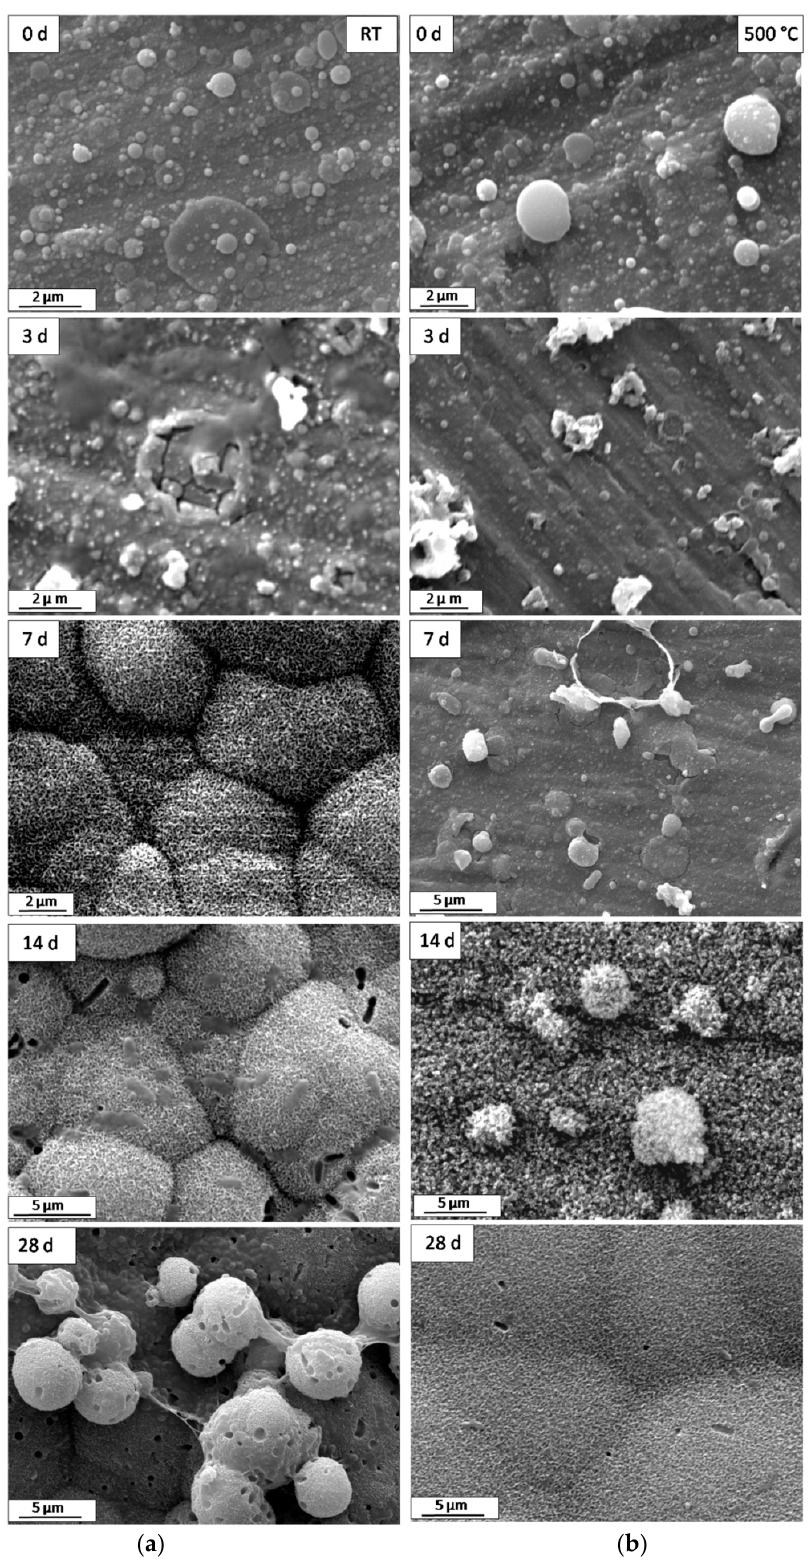
Figure 5. Effect of film crystallinity on in vitro bioactivity: SEM images collected upon RKKP-Mn films deposited at RT ( a ) and 500 °C ( b ) after different immersion time points in SBF. Reproduced with permission from [146], copyright from 2018 Elsevier.